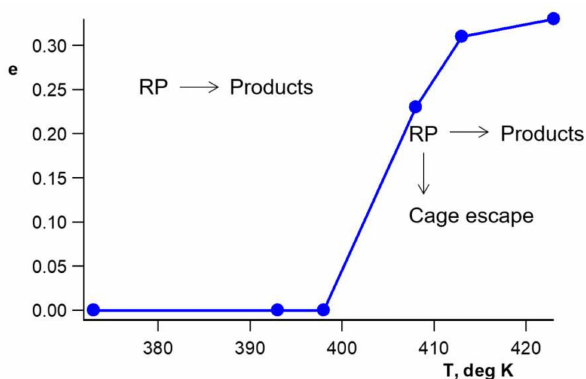
Figure 6. Plot of cage escape value e obtained at 298 K in B@BOPP films upon preheating temperature. Adapted from Ref.